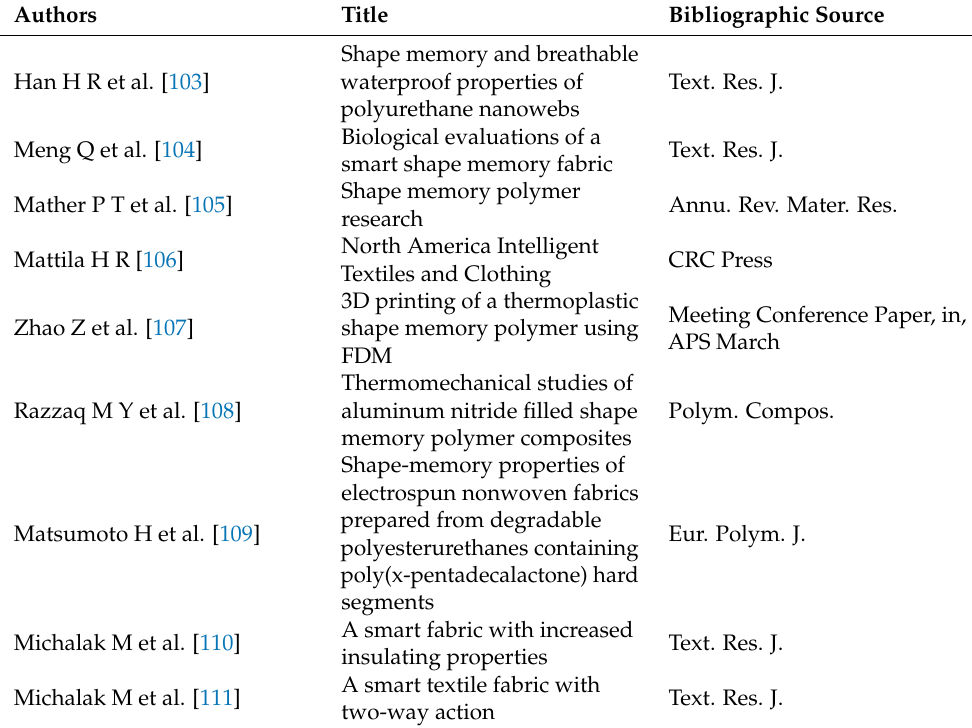
Table 6. Systematization/enumeration of shape memory papers with bibliographic